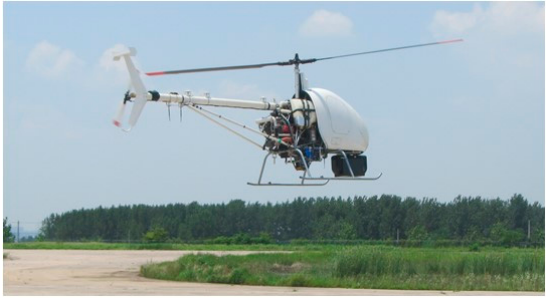
Figure 11. The experimental UH-based APLI system.